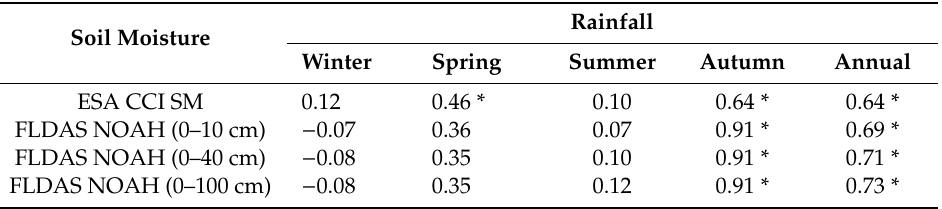
Table 4. The correlation between ASM anomalies at di ff erent depths and rainfall anomalies at the seasonal and annual scale from